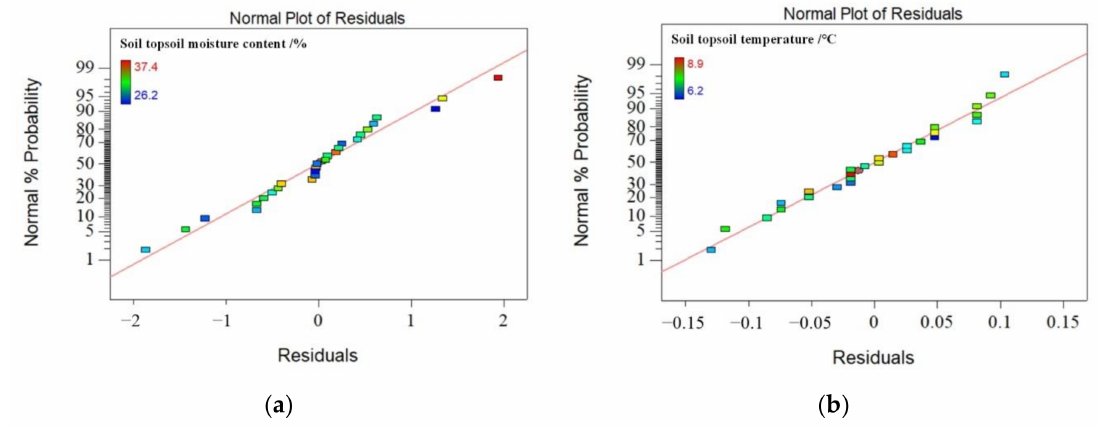
Figure 2. Residual normal diagram. ( a ) Residual normal diagram of soil topsoil moisture content; ( b ) normal diagram of soil topsoil